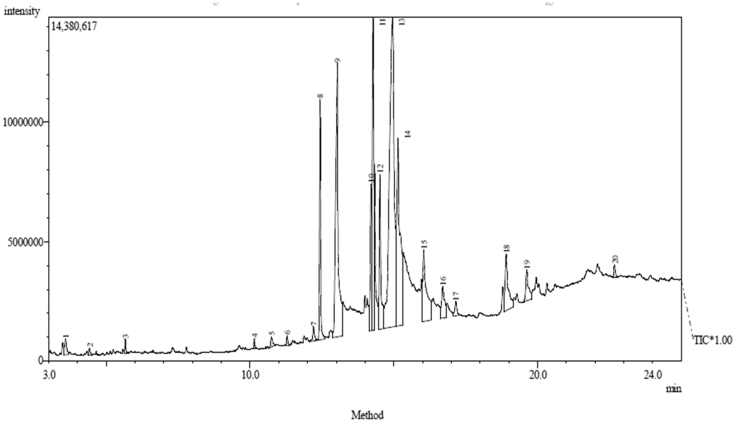
GC-MS Chromatogram of hexane extract of the Carica papaya seed.